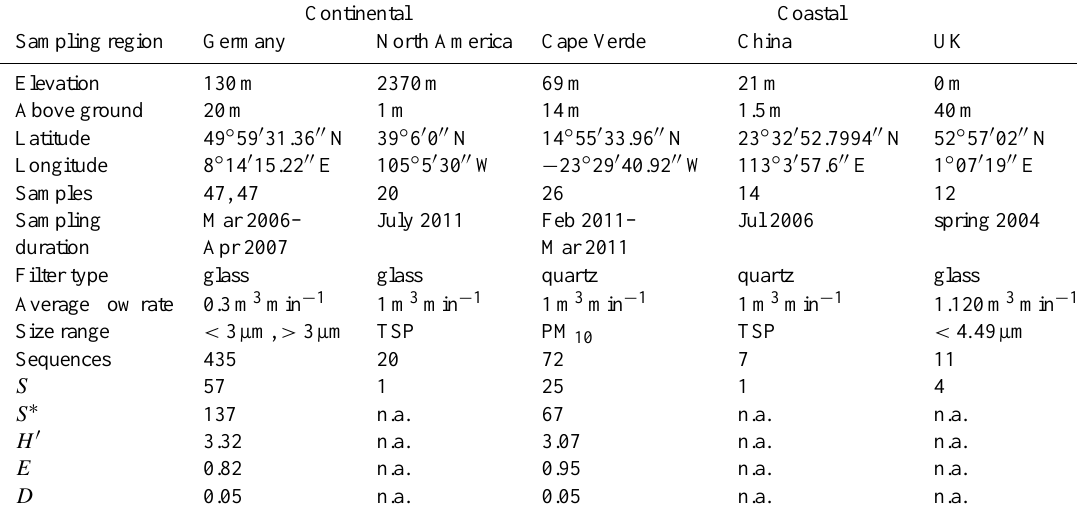
Table 1. Overview and diversity parameters of aerosol filter samples and detected archaea. Sampling details of continental and coastal sites are given: number of air samples, aerosol size range (total suspended particles (TSP) and particulate matter (PM)), and obtained number of DNA sequences. Statistical parameters: species richness ( S measured, S ∗ estimated), Shannon index ( H (cid:48) ), Shannon evenness ( E ), and Simpson’s index ( D ), not available (n.a.; see also Table S3). The measured species richness S in North America, China, and UK needs to be interpreted with caution as only few sequences were